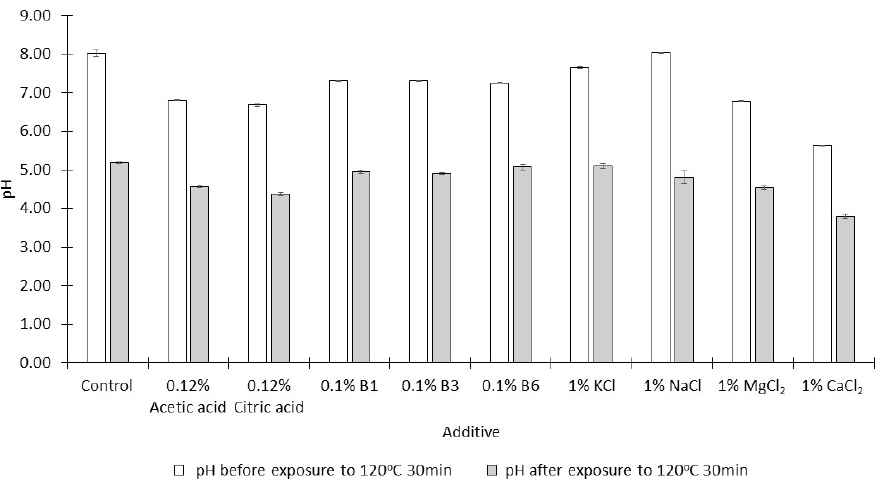
Figure 2. The pH of mixtures (mean ± SD, n = 3) containing single additives before and after heating at 120 °C for 30 min.